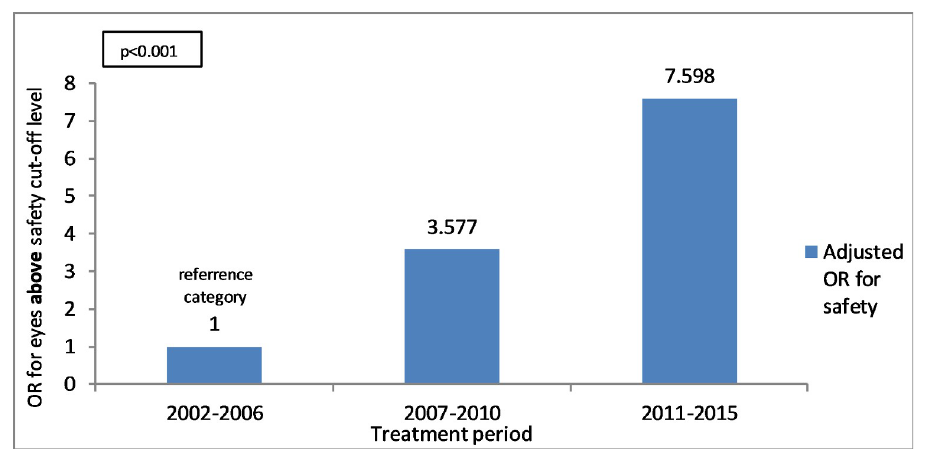
Fig 4. Relation between treatment periods and OR (Odds Ratio) for eyes above safety index cut-off level using multivariate analysis and logistic regression model (p < 0.001). OR value is regarding the reference category.